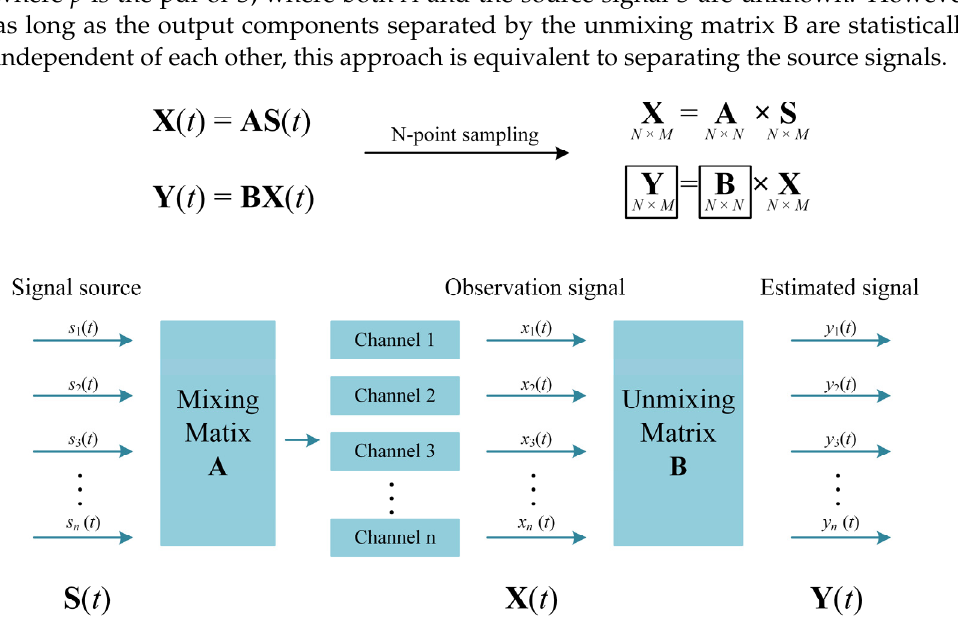
Figure 4. Schematic illustration of independent component analysis.